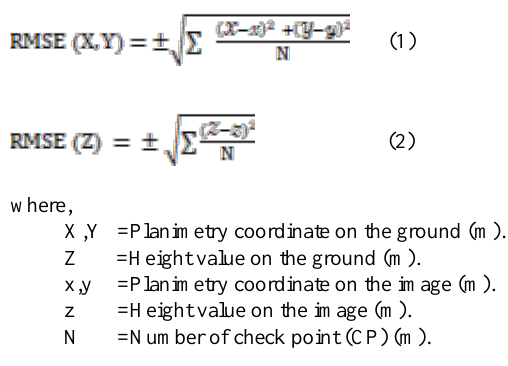
Figure 4. Orthophoto (Left) and DEM (Right) from Ebee UAV